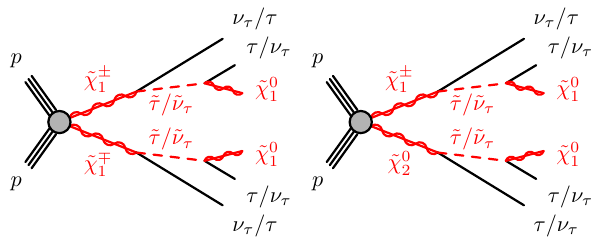
Fig. 1 Representative diagrams for the electroweak production and decay processes of supersymmetric particles considered in this work: + ˜ χ − ˜ χ 0 ˜ χ ± (left) ˜ χ 1 1 and (right) 1 2